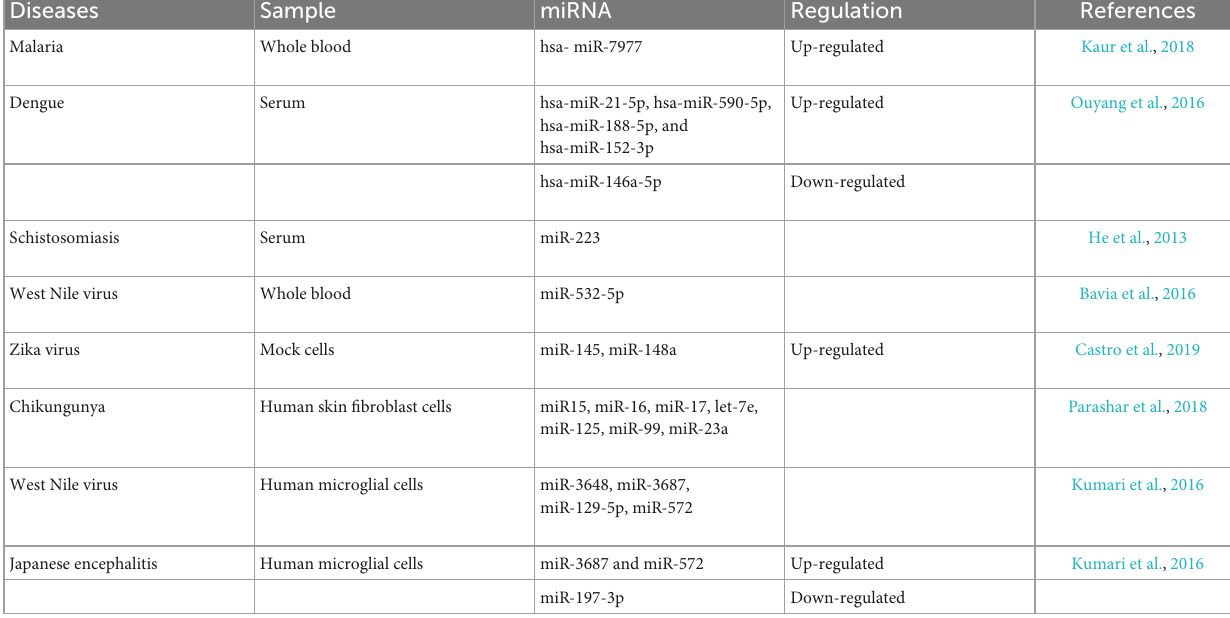
TABLE 4 Exosomal miRNA expression in different vector-borne diseases. Vector-borne